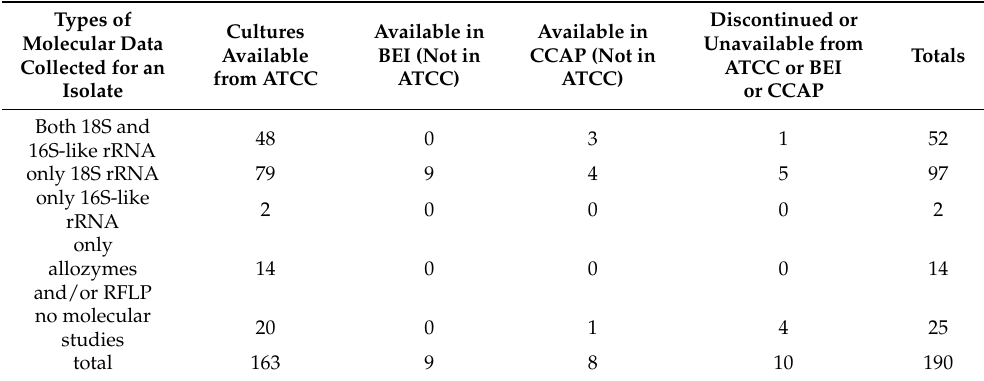
Table 1. Summary of standard strain Acanthamoeba cultures available from the culture centers or discontinued, as analyzed using molecular